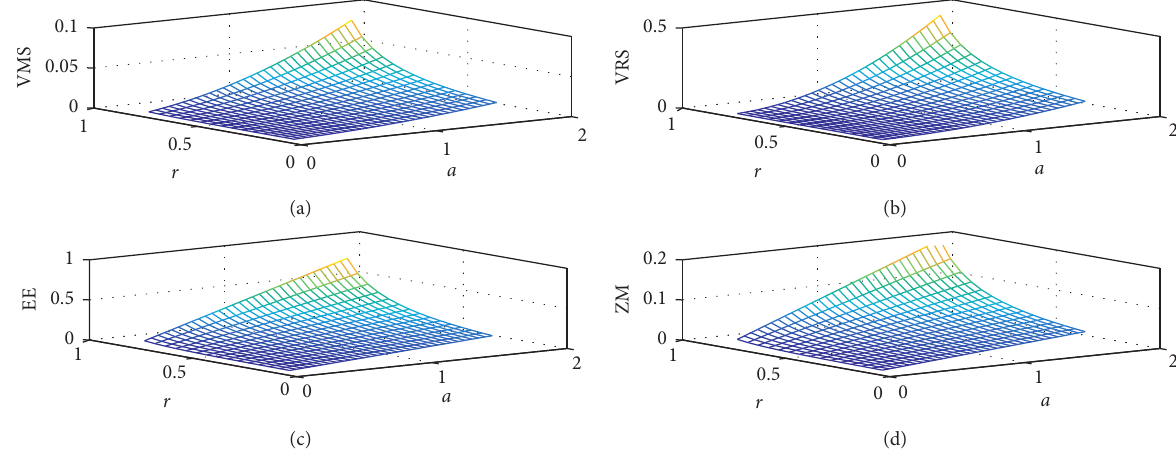
Figure 4: Sensitivity analysis of efforts influence coefficient and cost subsidy